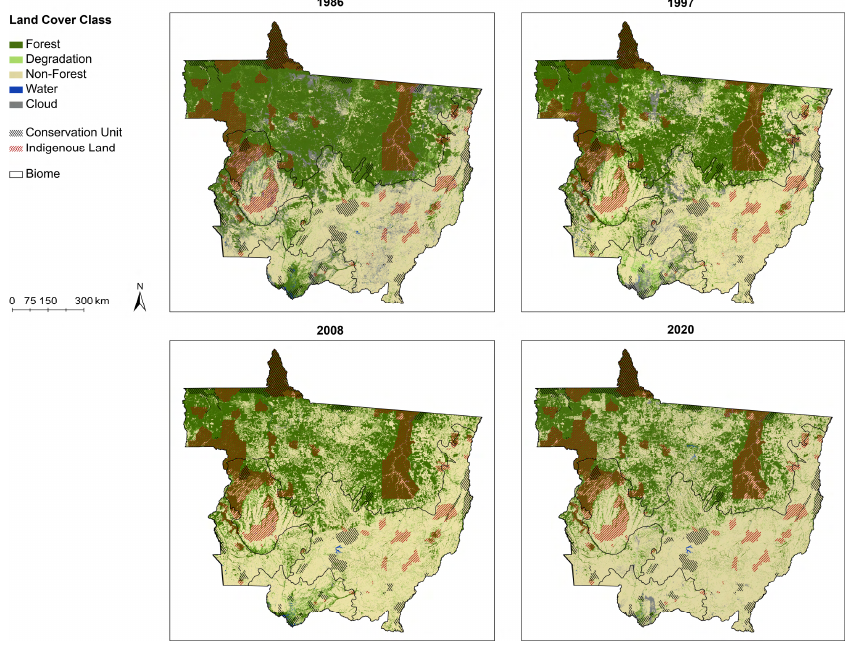
Figure 8. Land cover classifications of the years 1986, 1997, 2008, and 2020 (data basis: